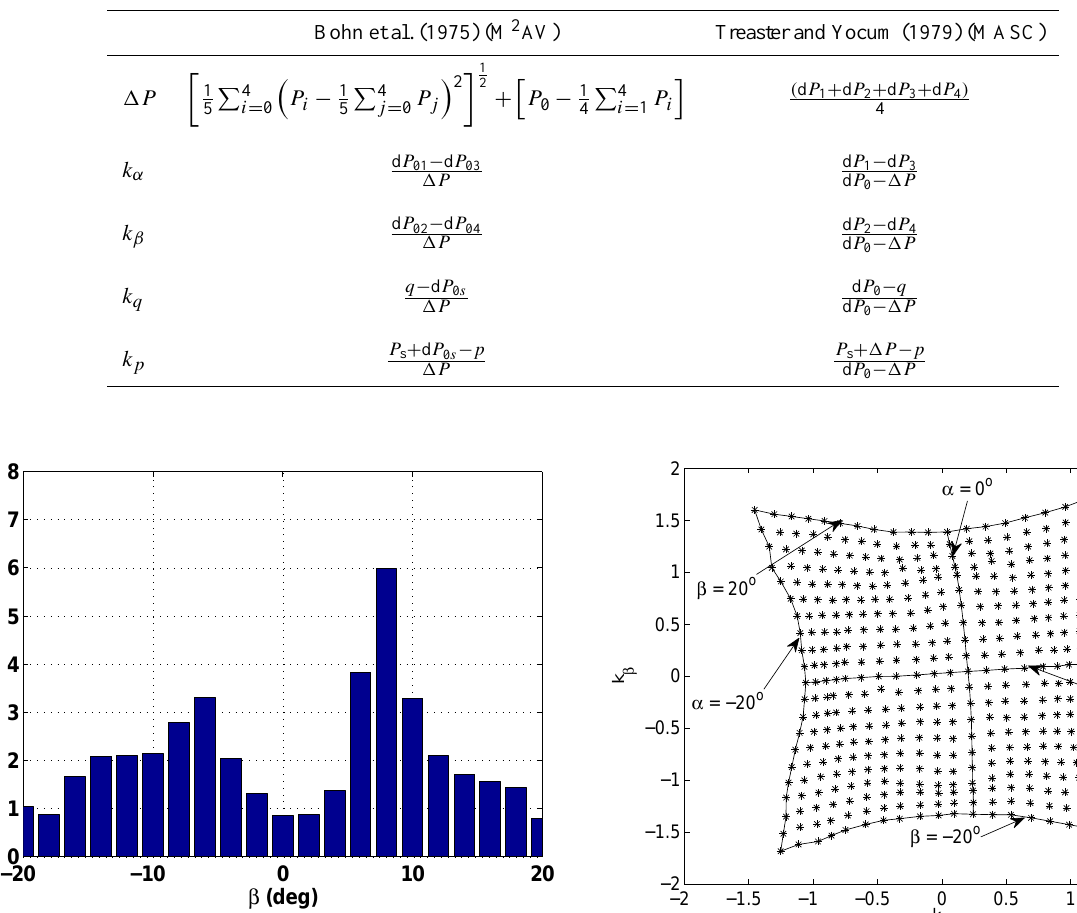
Table 1. Comparison of two methods to define dimensionless coefficients for five-hole probe measurements.